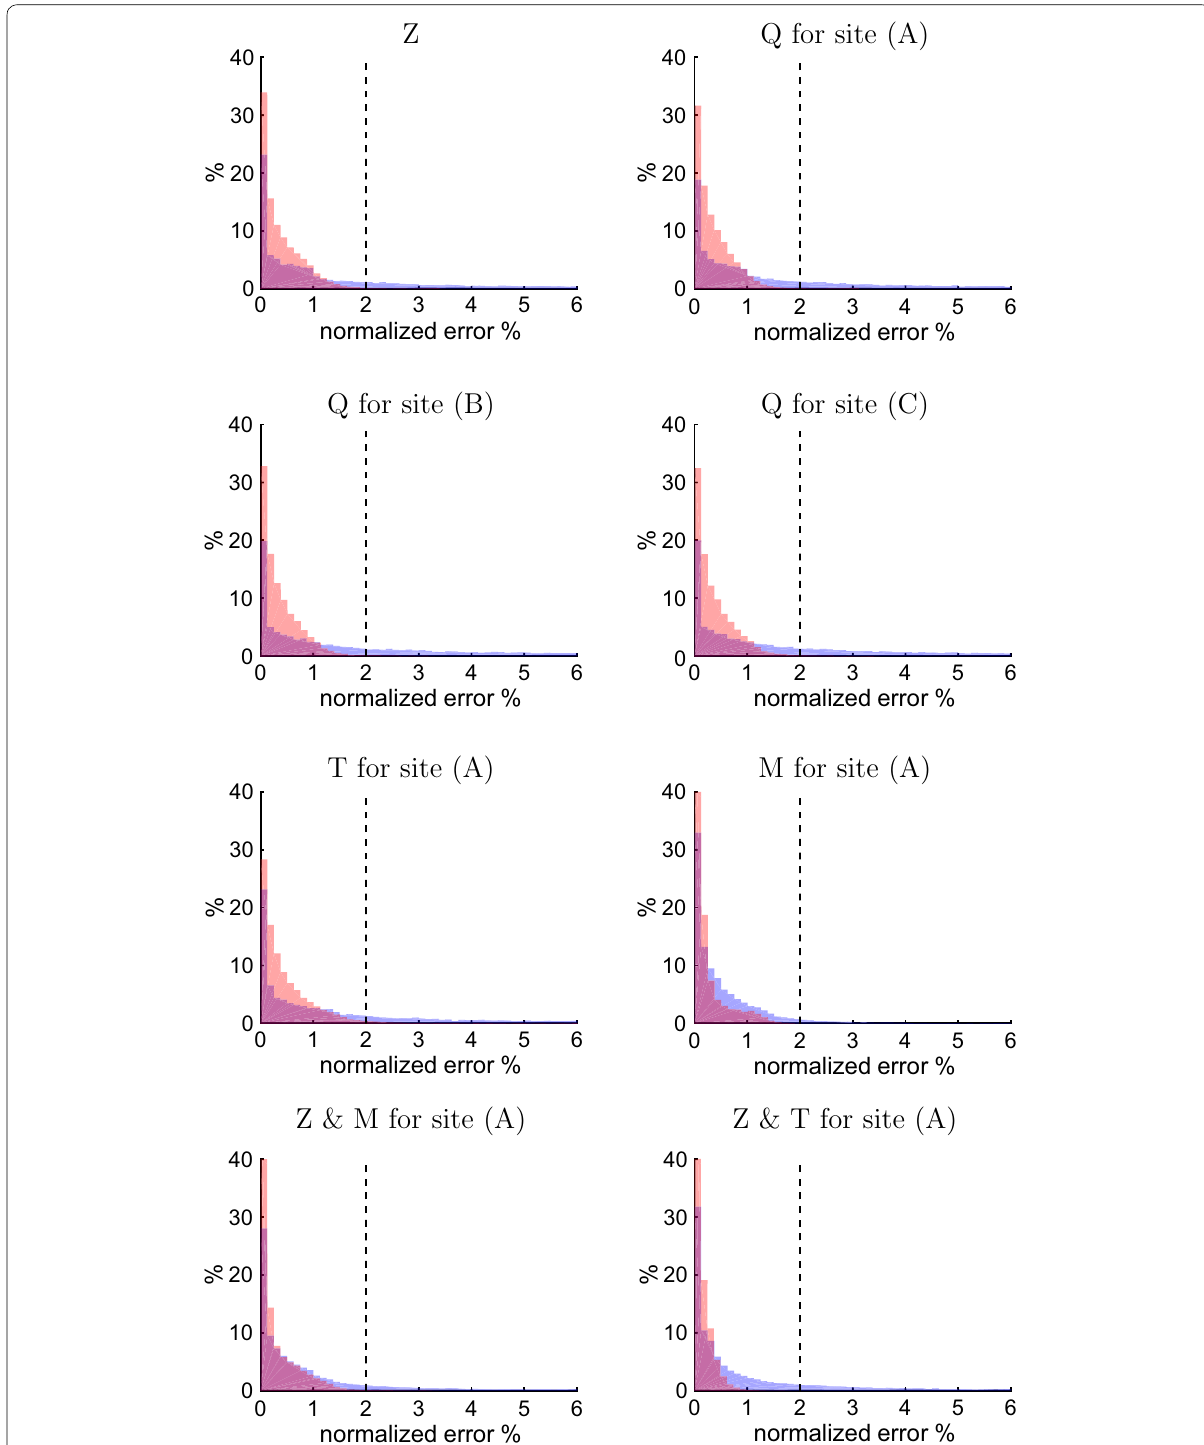
Fig. 3 From left to the right and from top to bottom: cumulative (all periods, all sites, all components of corresponding tensors) histograms of absolute values of normalized errors for Z , Q , T , M , Z and M , and Z and T . Three plots for Q show the results for three different locations of base site. Violet- and pink-coloured histograms stand for the cases when responses for starting and recovered models, respectively, were used for calculating errors. Vertical dashed line depicts target 2% error